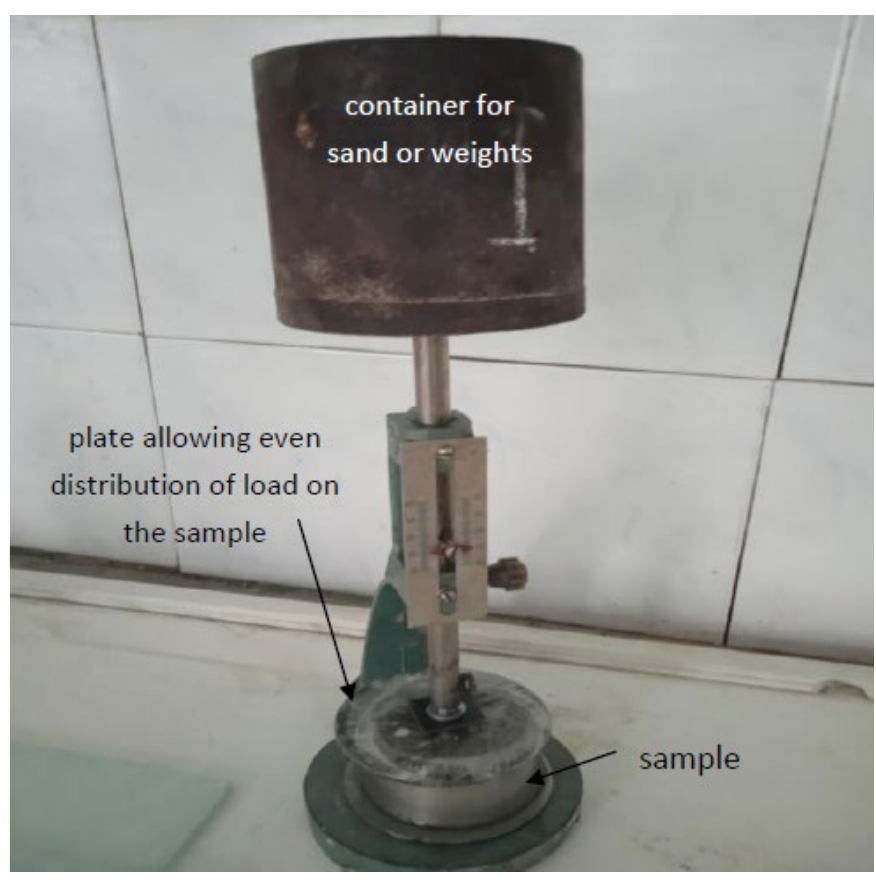
Figure 2. Device for determining the structural strength.